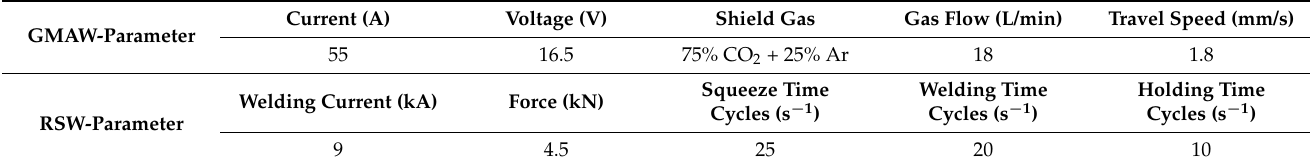
Table 3. Selected welding parameters for GMAW data from [20] and RSW data from [30] .